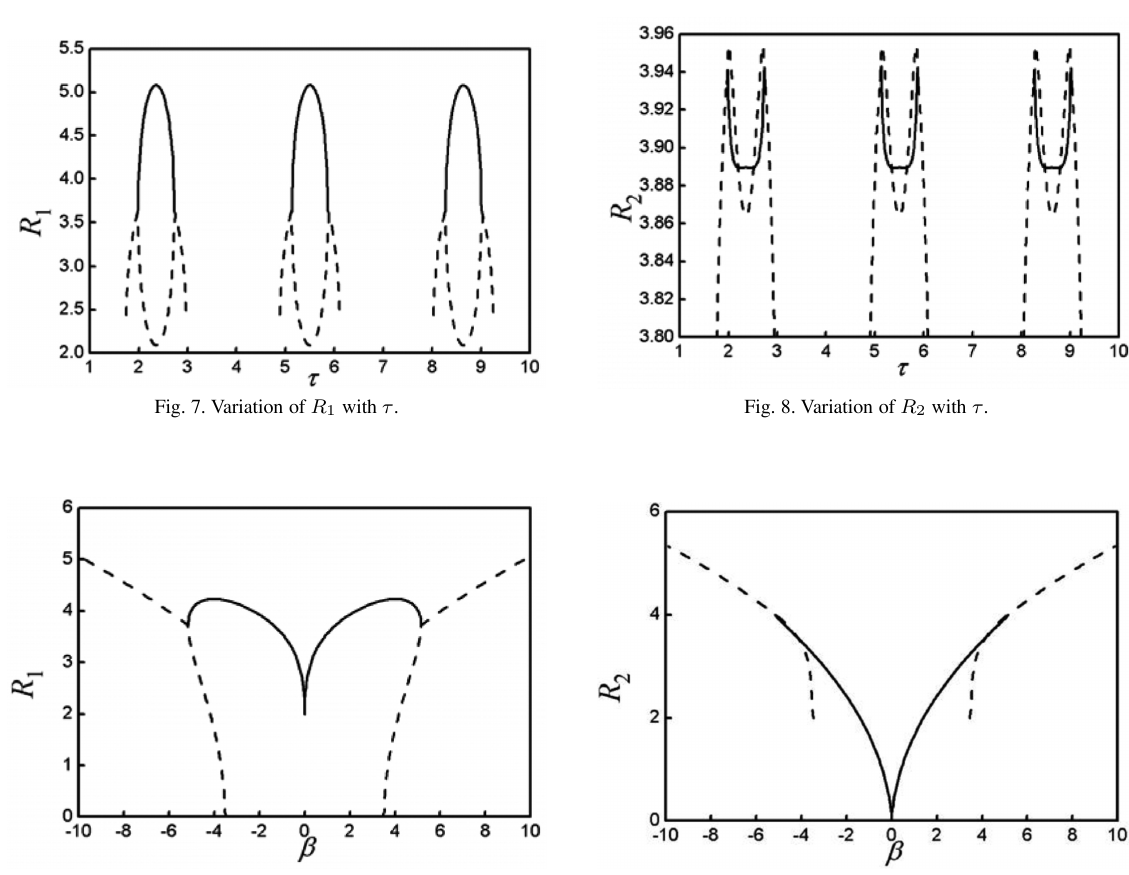
Fig. 9. Variation of R 1 with β , τ = 2. Fig. 10. Variation of R 2 with β , τ = 2.